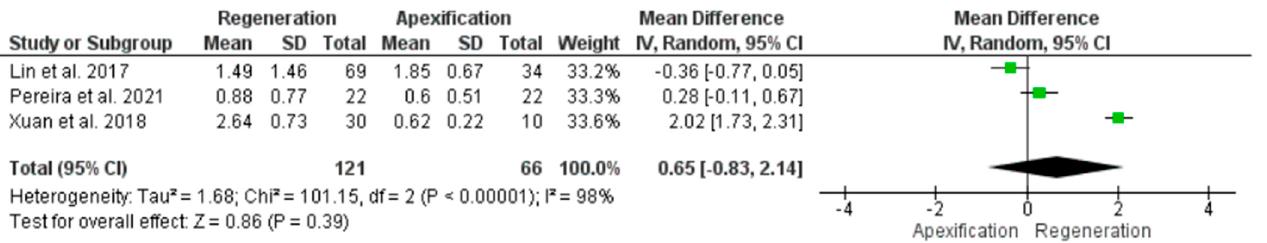
Figure 14. Meta-analysis of apical foramen width (AFW) in young immature teeth treated with re- generative endodontic procedure (REP) or apexification procedure.